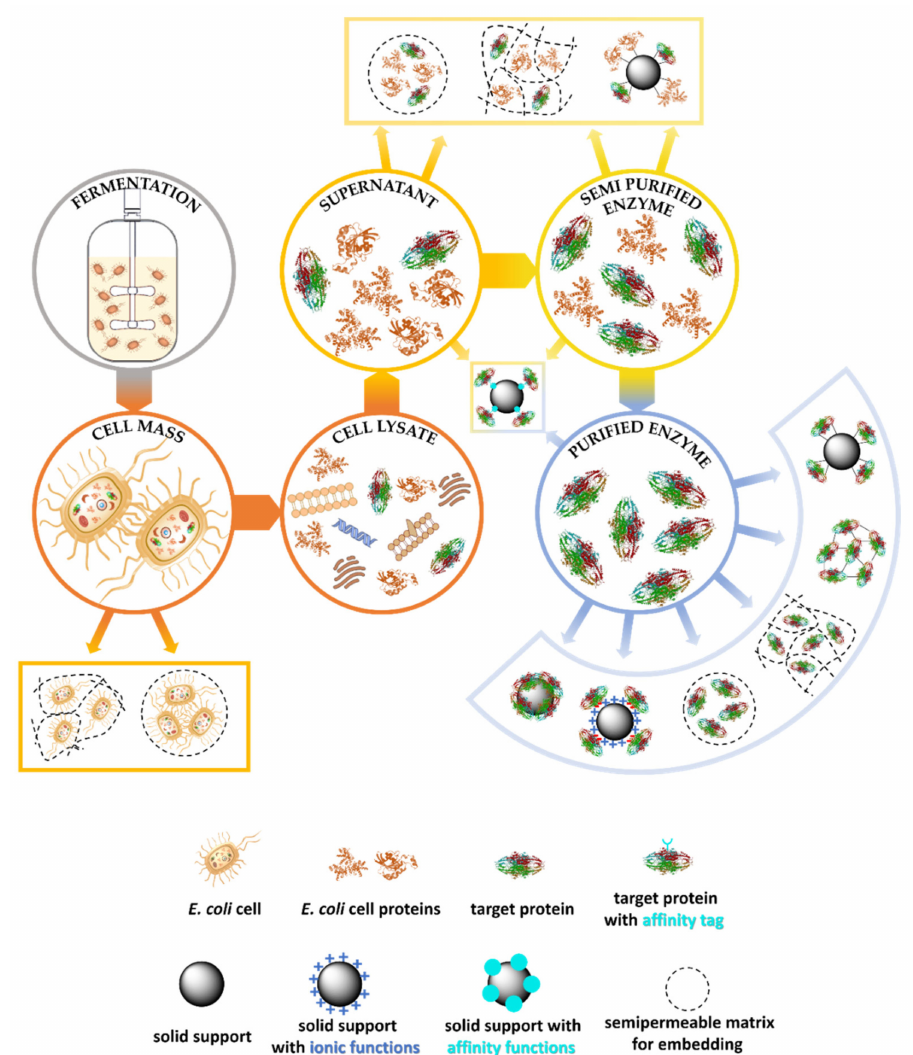
Figure 1. Possible shortcuts of the downstream process during immobilized biocatalyst